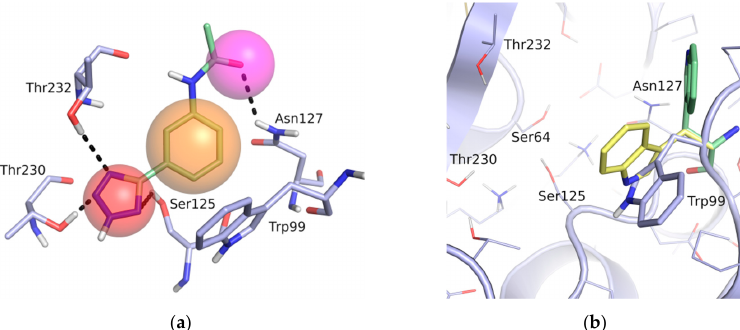
Figure 2. ( a ) Pharmacophore model for GES-5 ligands. Pharmacophore features (red: hydrogen-bond acceptor, orange: hydrophobic interaction feature, purple: hydrogen-bond donor) in the binding site of GES-5 superimposed with a fragment of the ligand 0J6 bound to CTX-M-9 β -lactamase (PDB code 4DE1). ( b ) Conformation of Trp99 found in GES-5 (PDB code 6TS9, blue) and KPC-2 (PDB code 3RXW, yellow: conformation A, green: conformation B). Conformation A of KPC-2 and the conformation found in GES-5 were used for virtual